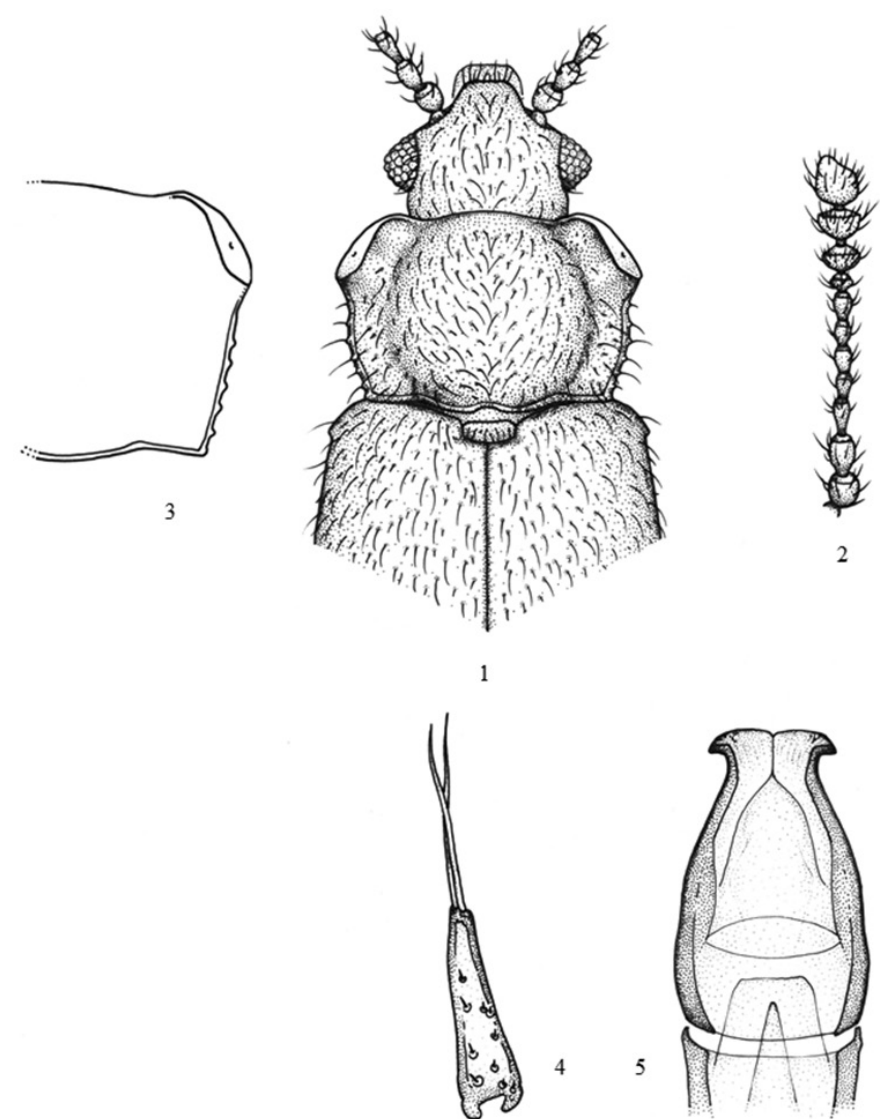
Figures 1–5. Micrambe apicalis : 1 General view 2 antenna 3 pronotum 4 paramere 5 aedeagus. Material examined. Holotype ♂ . Madagascar. C. 4 km N. of Ambohimahamasoa (forêt Fianaratsoa) 1200-1300 m; 22. III. 1996, 1 ♂ (leg. J. Janak and P. Moravec) (MHNG). Prov. Tamatave, Moramanga env. 25-27. XI. 1995, ♂ (leg I. Jenis) (MHNG). Tananarive, 6–13.X.1970, 1 ex (coll. P. Hammond) (BMNH). Additional material not examined. Madagascar. Forêt de Tanala (MNHN, not